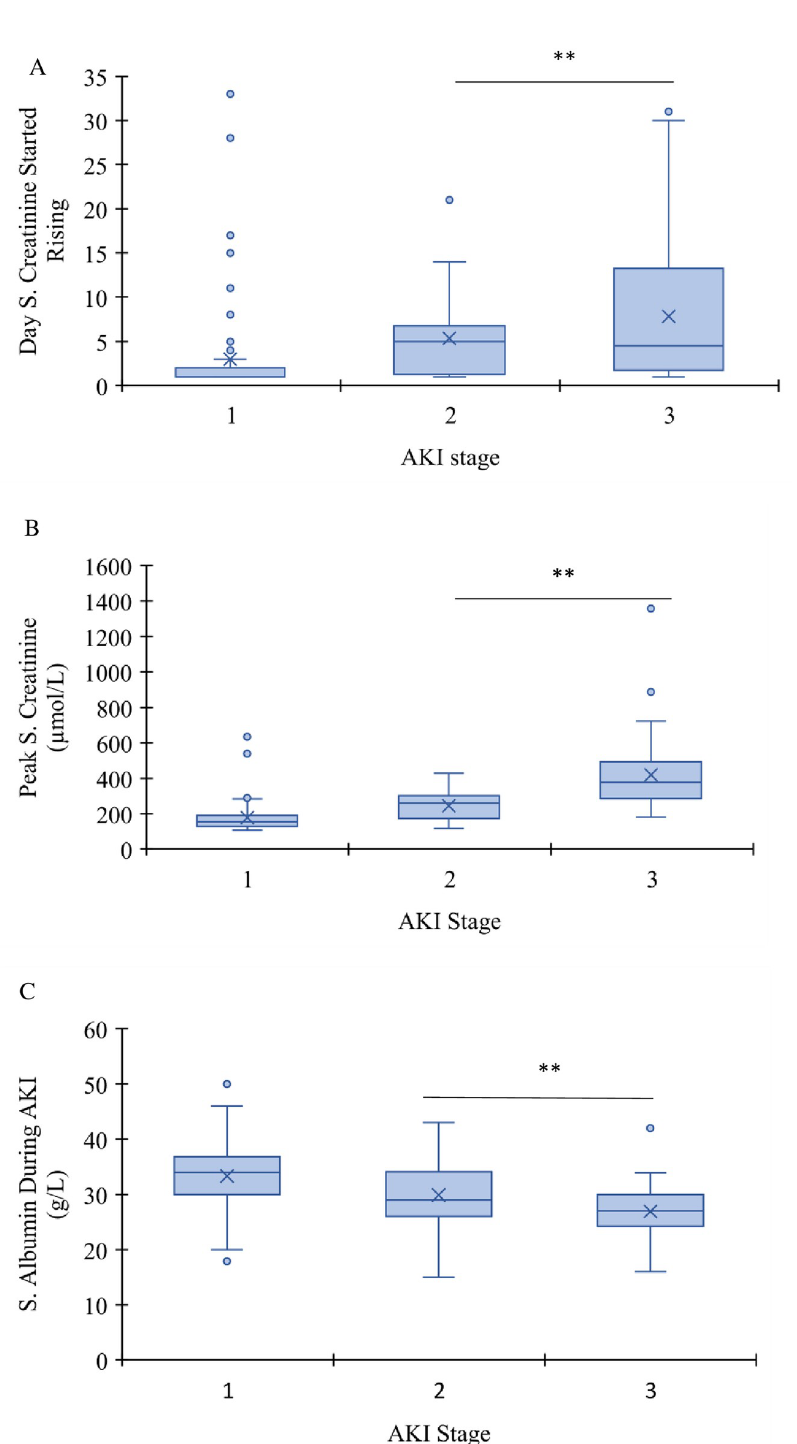
Fig 1. Box plot of number of days for serum creatinine started rising following hospitalization (A), peak level of serum creatinine (B), and serum albumin (C) in AKI groups. In either case, AKI stage I was significantly different than AKI stage II or III (For serum creatinine was faster to rise, but less peak value of creatinine, and for serum albumin was higher; �� p < 0.001).